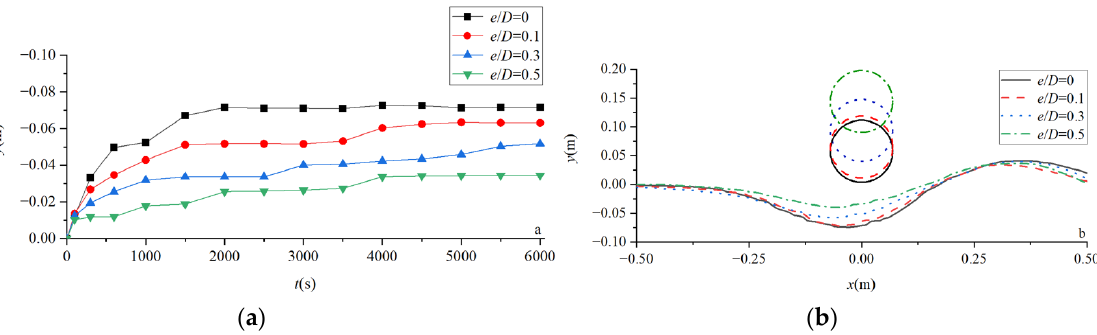
Figure 11. Comparisons of scour depth and terrain under the pipeline for a different initial gap. ( a ) The scour depth and ( b ) The scour terrain. ( a ) The scour depth and ( b ) The scour